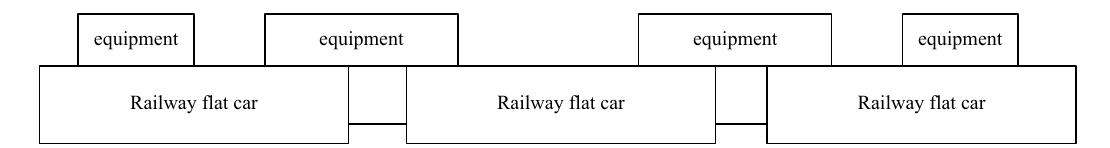
Figure 4: Wrong loading method: generate continuous straddle